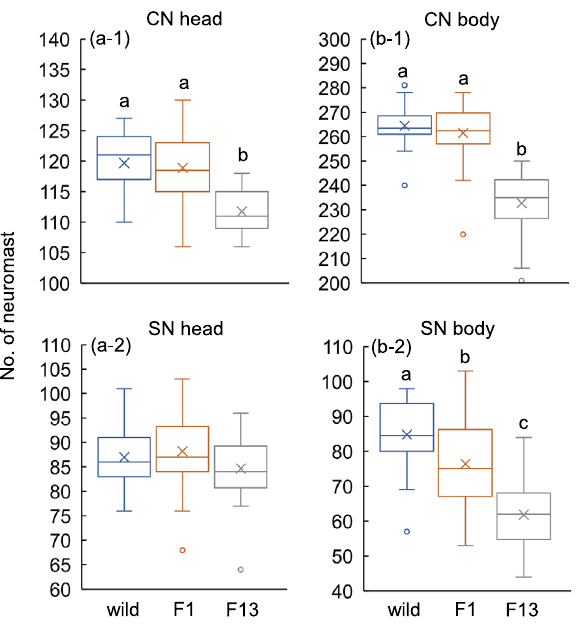
Figure 3. Comparisons of neuromast numbers (CNs and SNs) on the head and body of wild, F1 and F13 Oncorhynchus masou masou from the Shiribetsu anadromous population. Different letters (a, b, c) indicate significant differences detected by Scheffe’s test following univariate ANOVA (p < 0.05). Boxplots show 25, 50 and 75 percentiles, maximum and minimum values without considering outliers, and mean values